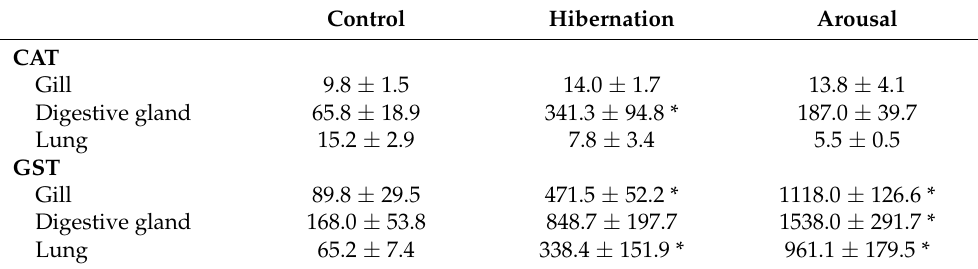
Table 2. Antioxidant enzymes activity in tissues of Pomacea canaliculata exposed to short-term activity- hibernation-arousal cycle. CAT: catalase; GST: glutathione S-transferase. Mean ±